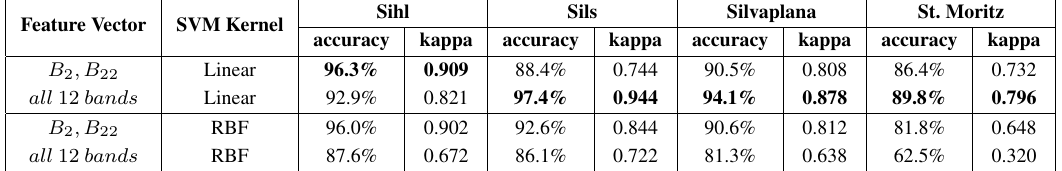
Table 10: Generalization across winters: MODIS results when the SVM is trained with data from winter 2011 - 12 and tested with data from winter 2016 - 17 .